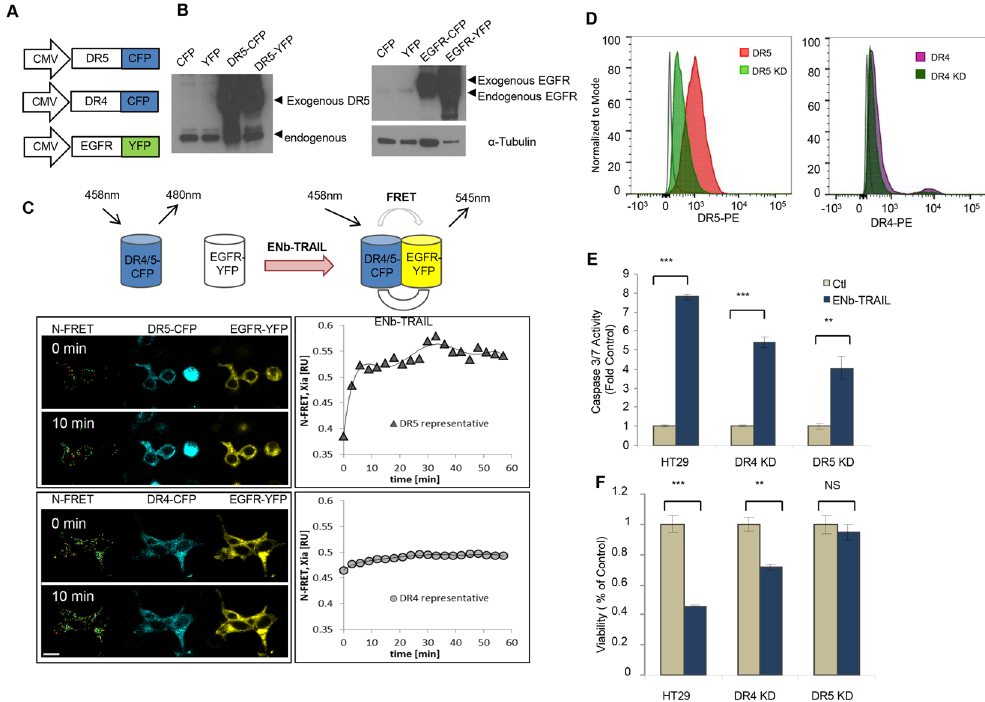
Figure 3. TRAIL receptor DR5 plays a major role in ENb-TRAIL-induced apoptosis. ( A ) Schematic showing DR4/5-CFP and EGFR-YFP fusion protein constructs. ( B ) Western blot analysis of DR5-CFP/YFP and EGFR- CFP/YFP expression in 293 T cells. ( C ) Changes in FRET signal between DR4/5-CFP and EGFR-YFP post treatment with ENb-TRAIL in 293 T cells. The left panels show frames from time lapse collection of DR5-CFP or DR4-CFP + EGFR-YFP signals and calculated N-FRET index (Xia); index is not calculated for overexposed signal. Right panel: The quantification of N-FRET index over 1 h period. Cells were treated with ENb-TRAIL at time 0 min. ( D ) Flow cytometry analysis of membrane DR5 or DR4 level in knocked down (DR5 KD, DR4 KD) HT29 cells. ( E ) Caspase 3/7 activity assay and ( F ) cell viability assay analysis of DR5 or DR4 KD effect on ENb- TRAIL induced apoptosis. * P < 0.05, ** P < 0.005 and *** P = 0.0001 determined by unpaired t test. Error bars indicate SD. Western blots were cropped to show specific bands only. For uncropped blots see Fig.